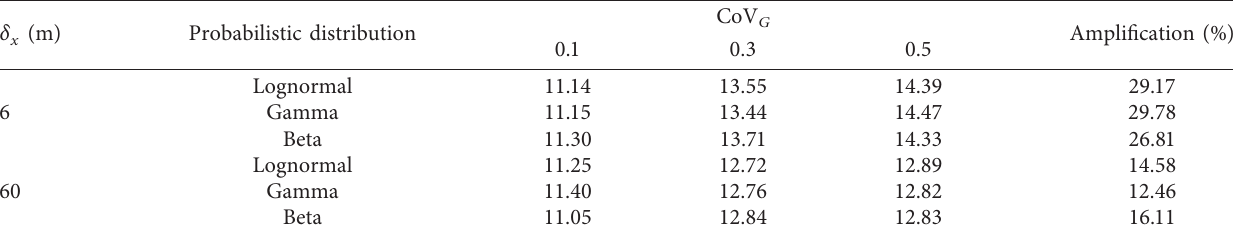
Table 3: Variation of dissipation rate of μ